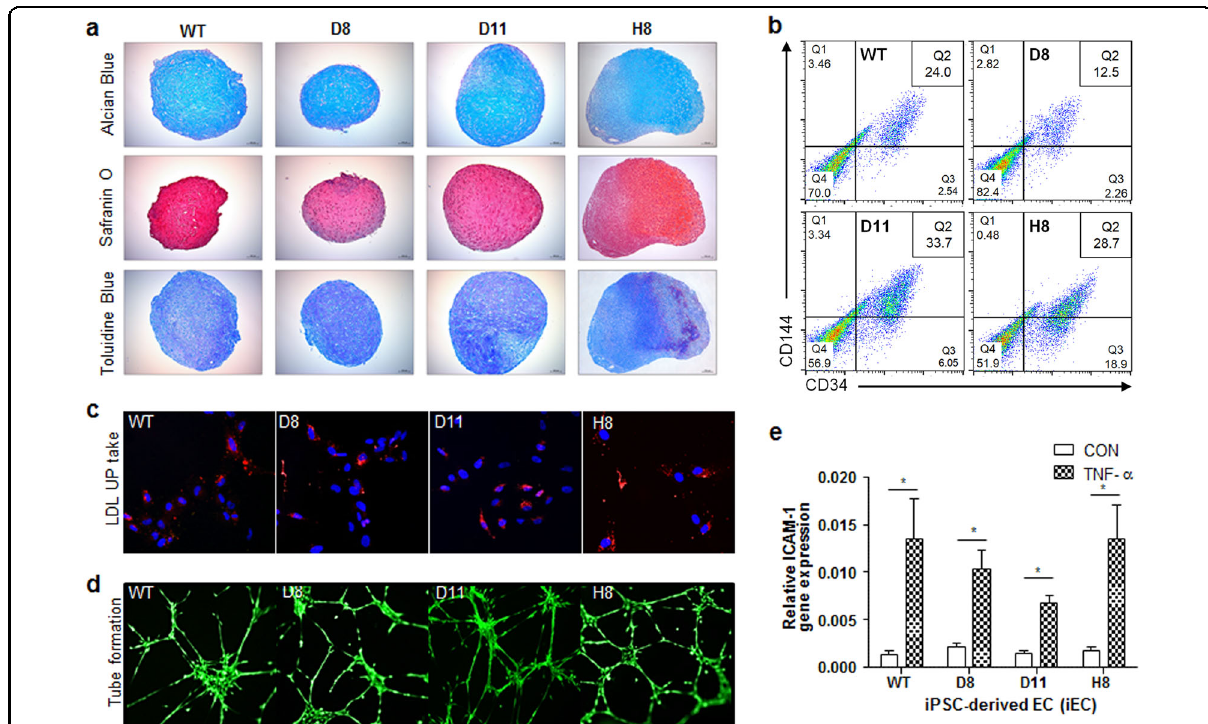
Fig. 4 Differentiation capacity analysis of HLA-B – engineered iPSC clones. Chondrogenic differentiation analysis of wild-type and HLA-B- engineered iPSC clones. Glycosaminoglycan, a major extracellular matrix in cartilage tissue, was stained with Alcian blue (Blue), Safranin O (Orange to red), and Toluidine Blue (Purple). Images were acquired on a Leica microscope (DM50003; scale bar, 100 μ m). b Endothelial cell differentiation of wild- type and HLA-B-engineered iPSC clones. The CD34- or CD144-positive population was evaluated in each clone by fl ow cytometry. c Florescent LDL uptake assay and d tube formation assay of the iECs derived from wild-type and HLA-B-engineered iPSCs. e TNF- α -induced expression of ICAM-1 in the iECs derived from wild-type and HLA-B-engineered iPSCs. One asterisk indicates a p- value less than